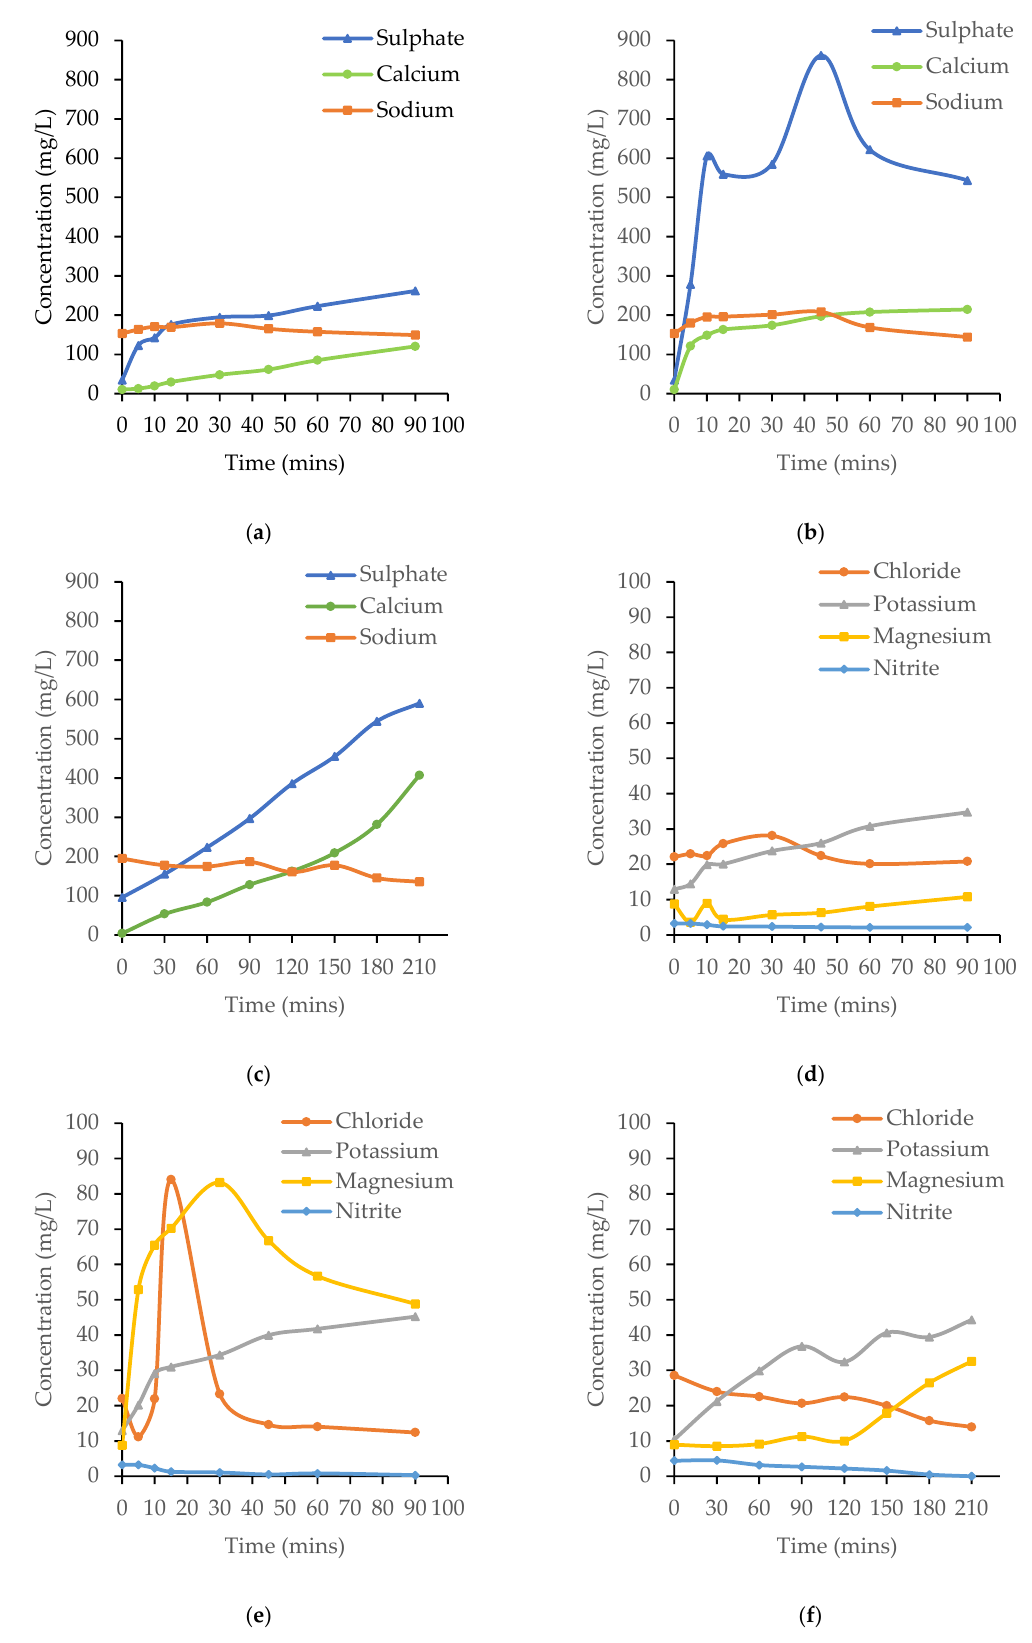
Figure 6. Concentrations of dissolved ions after oxidation with ( a , d ) WAO (90 min), ( b , e ) WAPO (90 min), and ( c , f ) WAO extended (210 min).